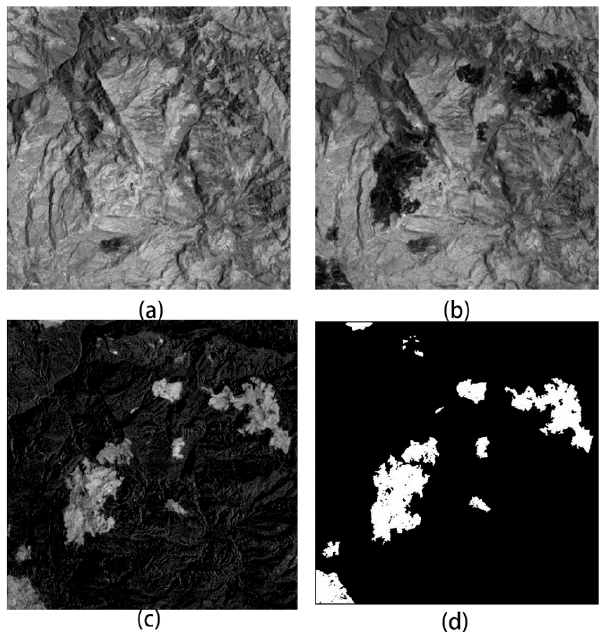
Figure 10. Third dataset: Mexico dataset, band 4 of the Landsat TM image captured in ( a ) April 2000; and ( b ) May 2002; ( c ) corresponding CMI generated through the difference method; and ( d ) reference of the changed area.